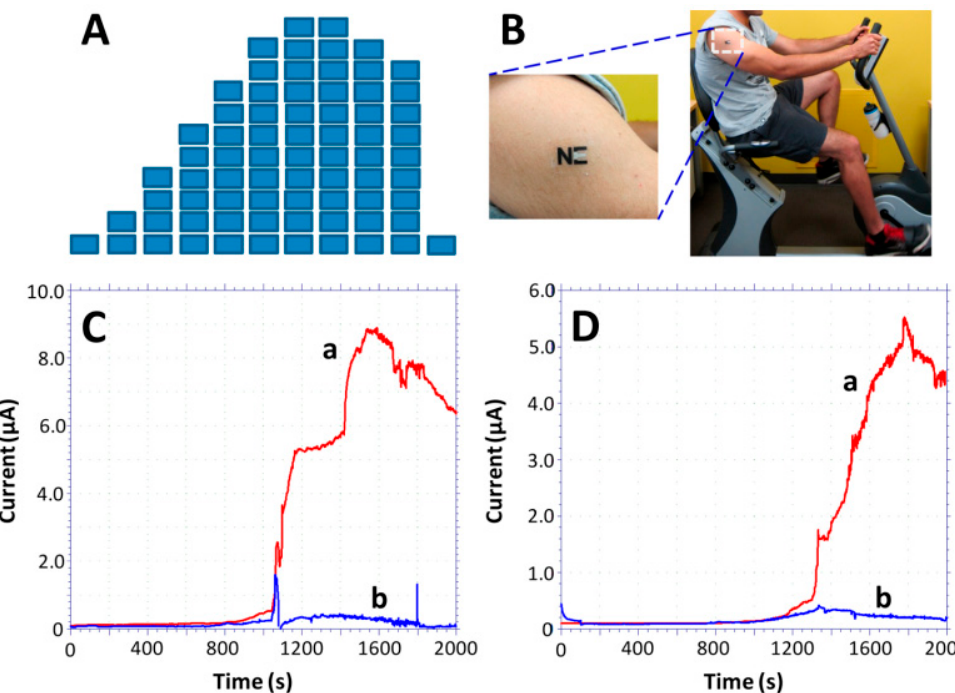
Figure 5. Monitoring of sweat lactate during 33 min of cycling exercise while changing the work intensity. ( A ) Exercise resistance profile on a stationary cycle. Subjects were asked to maintain a constant cycling rate while the resistance was increased every 3 min for a total evaluation of 30 min. A 3 ‐ min cool ‐ down period followed the exercise. ( B ) An “NE” lactate biosensor applied to a male volunteer’s deltoid; ( C and D ) Response of the LOx ‐ (a) and enzyme ‐ free (b) tattoo biosensors during the exercise regimen (shown in part A ) using two representative subjects. Constant potential, +0.05 V (vs. Ag/AgCl); measurement intervals, 1 s (reprint with permission from Jia et al. 2013; Ref. [203]. Copyright 2013 American Chemical Society ).